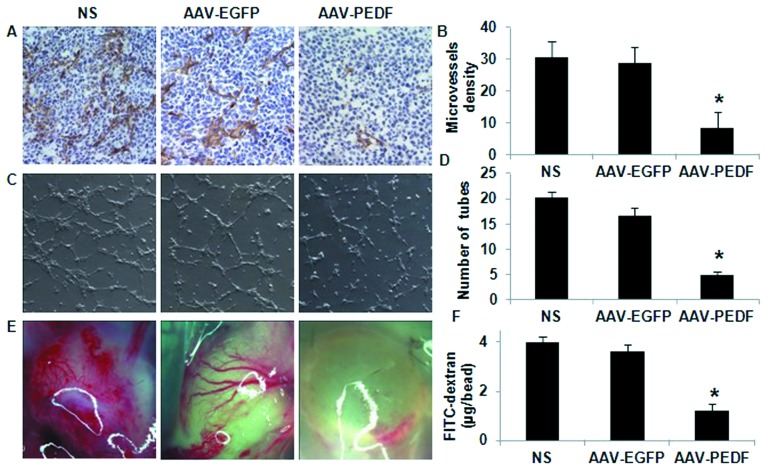
CD31 immunohistochemistry, tube formation, and Alginate-encapsulated tumour cell assay. (A) Micrographs show tumour tissue sections stained with anti-CD31 antibody (original magnification, ×400) after NS, AAV-EGFP, or AAV-PEDF treatment. (B) Quantitative results of microvessel density (MVD) in tumour tissue. The AAV-PEDF group showed a significant decrease in MVD compared to control groups (*P<0.05). Endothelial cells form tube and capillary-like structures on a Matrigel membrane through a process involving attachment, alignment and migration. (C) Treatment with conditioned medium (CM) from LLC cells infected in vitro with AAV-PEDF significantly decreased this process (original magnification, ×100). (D) The tube formations were quantified by counting the number of connecting branches between 2 discrete endothelial cells (*P<0.05). (E) Photographs show alginate bead surfaces from different groups. (F) FITC-dextran uptake in the tumour was significantly decreased in mice treated with AAV-PEDF compared to the control groups (*P<0.05).